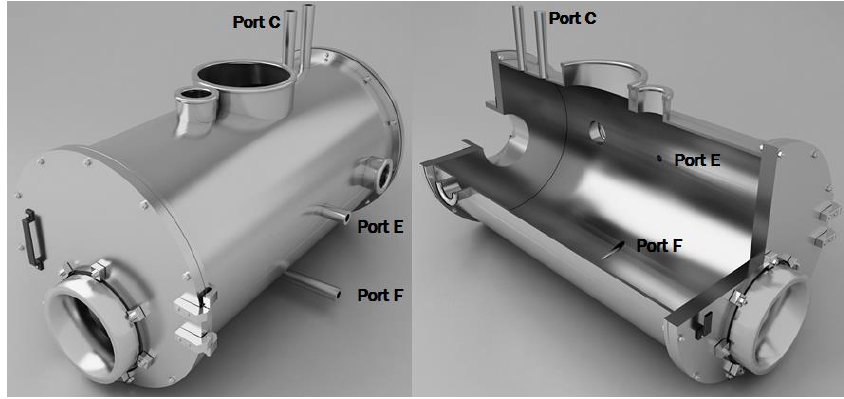
Figure 5. STARDUST-Upgrade facility rendering, showing ports C, E and F used in the present campaign.